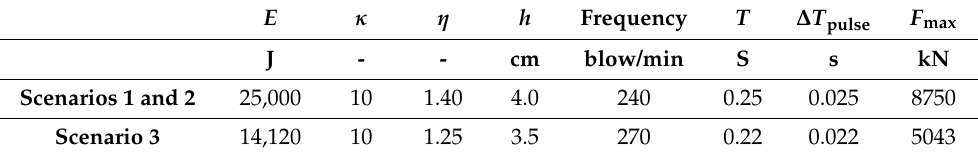
Table 3. Characteristics of the dynamic force simulating the hammer action.